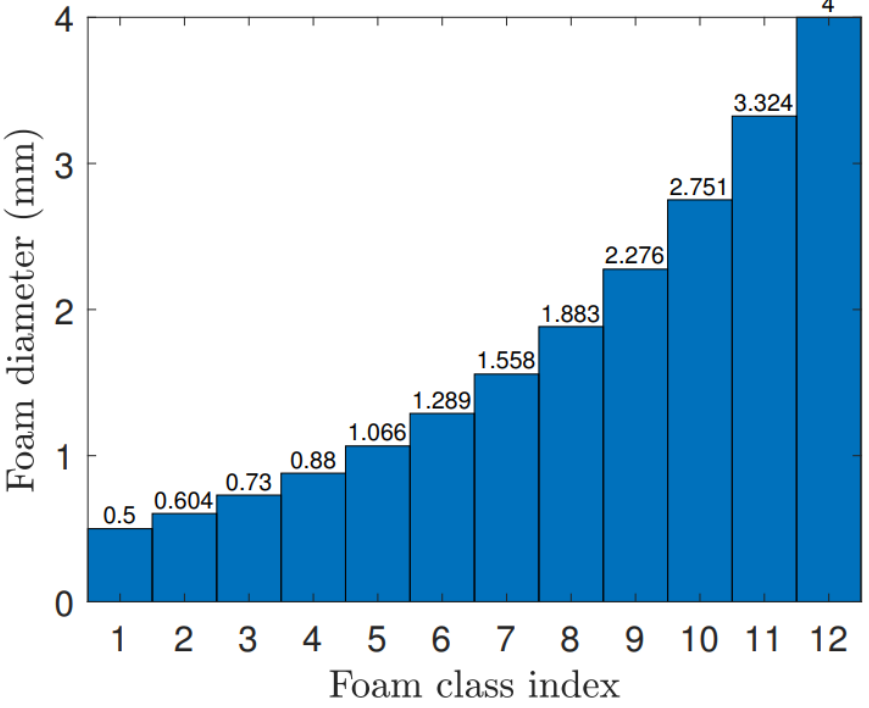
Figure 2. Distribution of the foam diameter, where twelve foam classes are adopted.